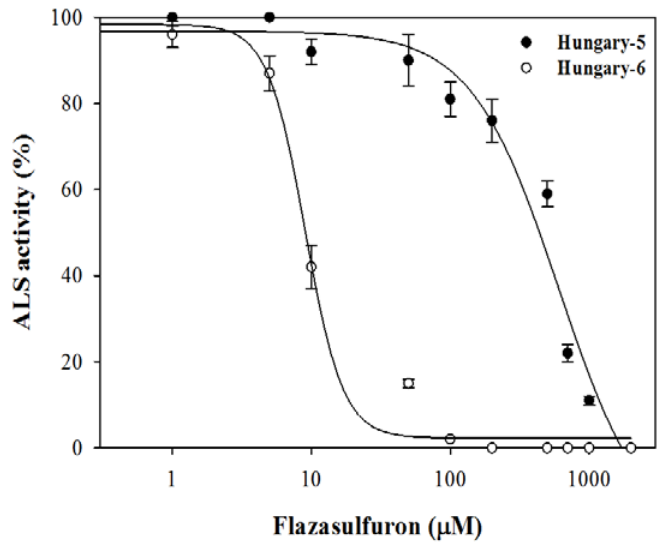
Figure 3. ALS enzyme activity was determined using flazasulfuron in the H-5 and -6 populations from Hungary. The equations of log–logistic curves to estimates the I 50 values are: H-5: Y = {(99.2)/[1 + (dose/I 50 ) 1.38 ]} and H-6: Y = {(100.4)/[1 + (dose/I 50 ) 3.21 ]}. Symbols denoted mean ( n = 15) ± standard errors.